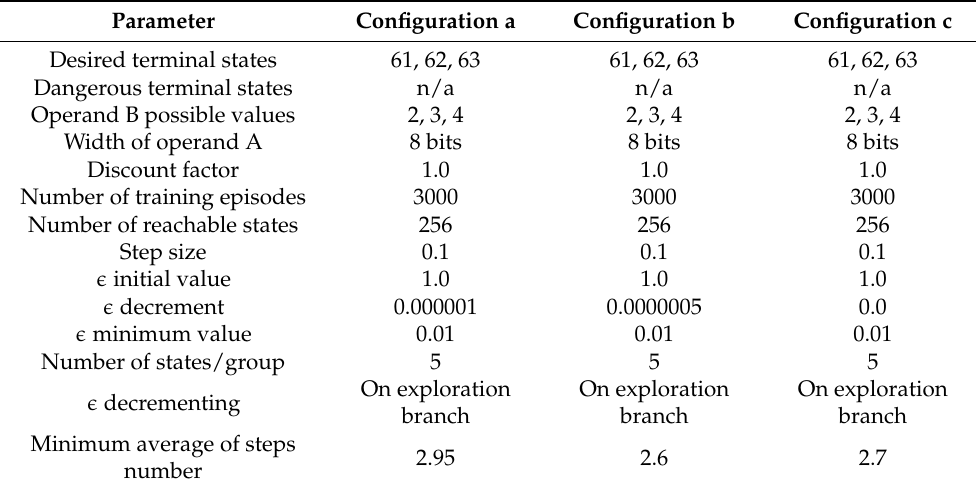
Table 13. Different training configurations and their best result after training 10 agents using each